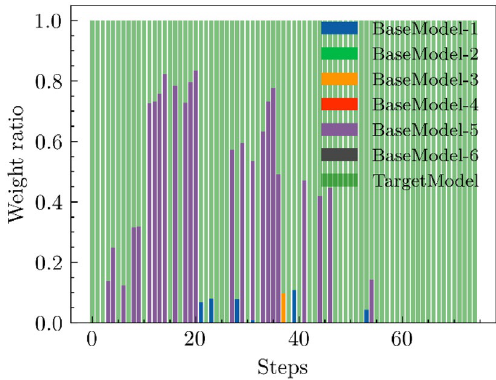
Fig. 10 Basic model weights in the ensemble